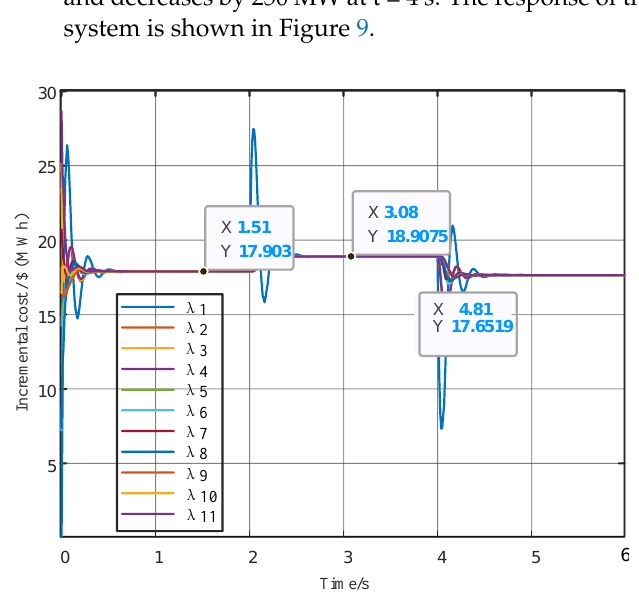
Figure 9. Incremental cost at p = 0.9.